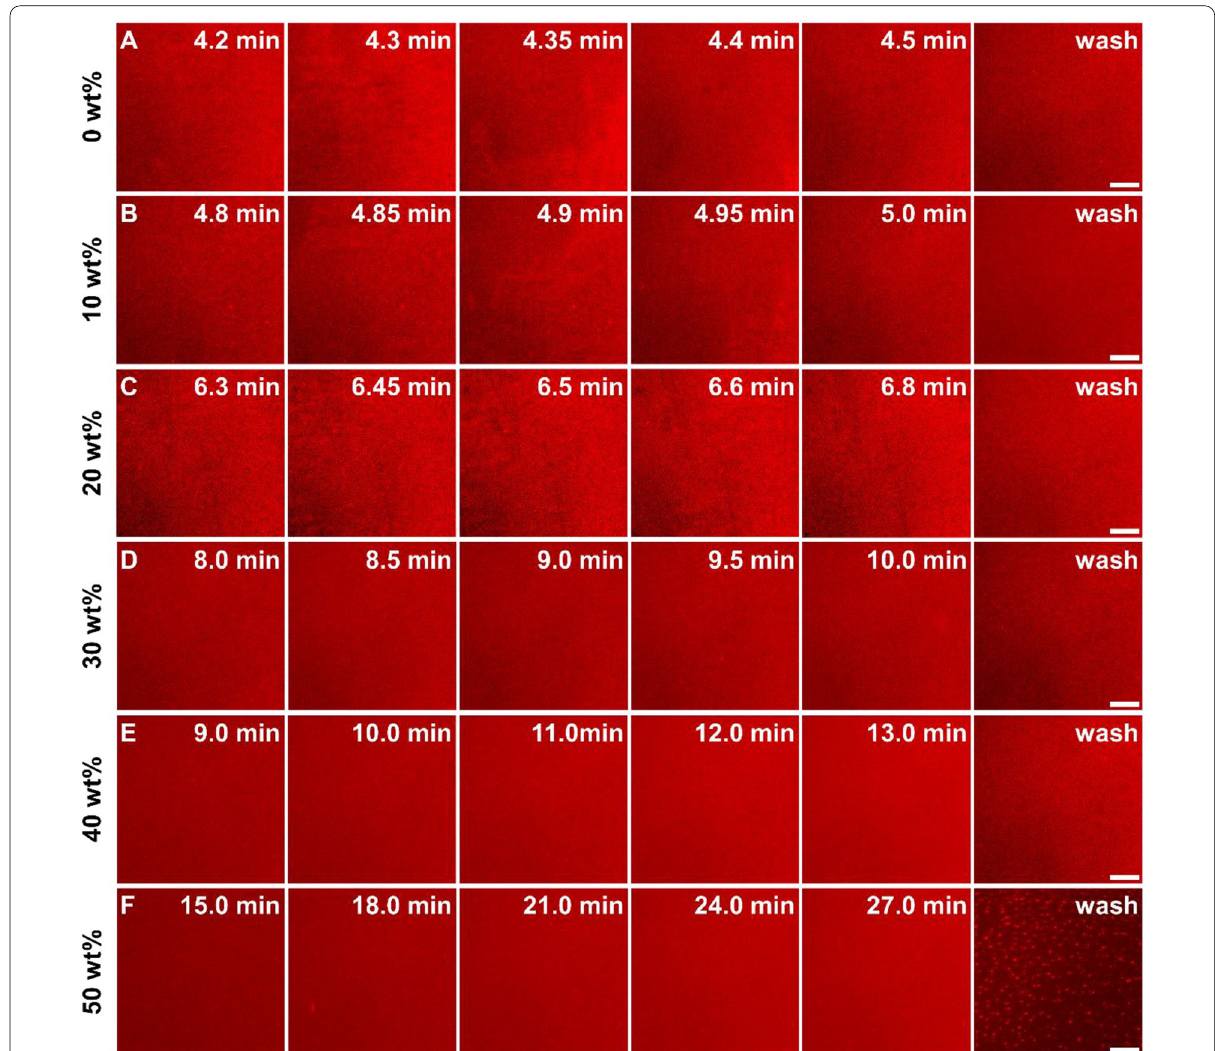
Fig. 2 Time‑lapse fluorescence micrographs of bicelle adsorption in various sucrose concentrations. For fluorescence microscopy imaging, bicelles were added onto a glass surface at t 0 min. The adsorption process in the following sucrose concentrations was then recorded: A 0 wt%, B = 10 wt%, C 20 wt%, D 30 wt%, E 40 wt%, and F 50 wt%. All scale bars are 20